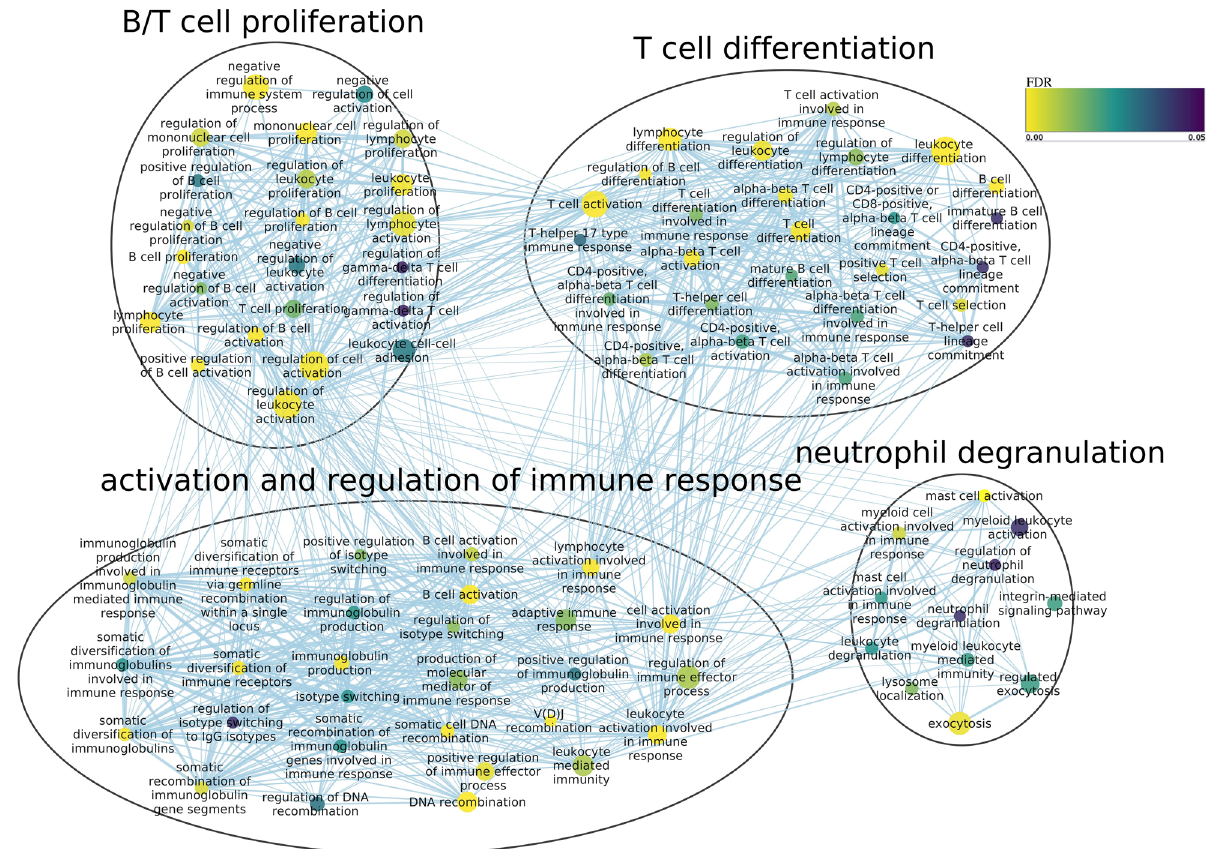
Figure 5. Sub-network from enriched GO terms by g:Profiler in PBMCs and visualized in Cytoscape after clustering with Autoannotate. Node size correspond to number of genes expressed from the term; edge size represents the number of genes that overlap between different terms; node colour represents the significance level